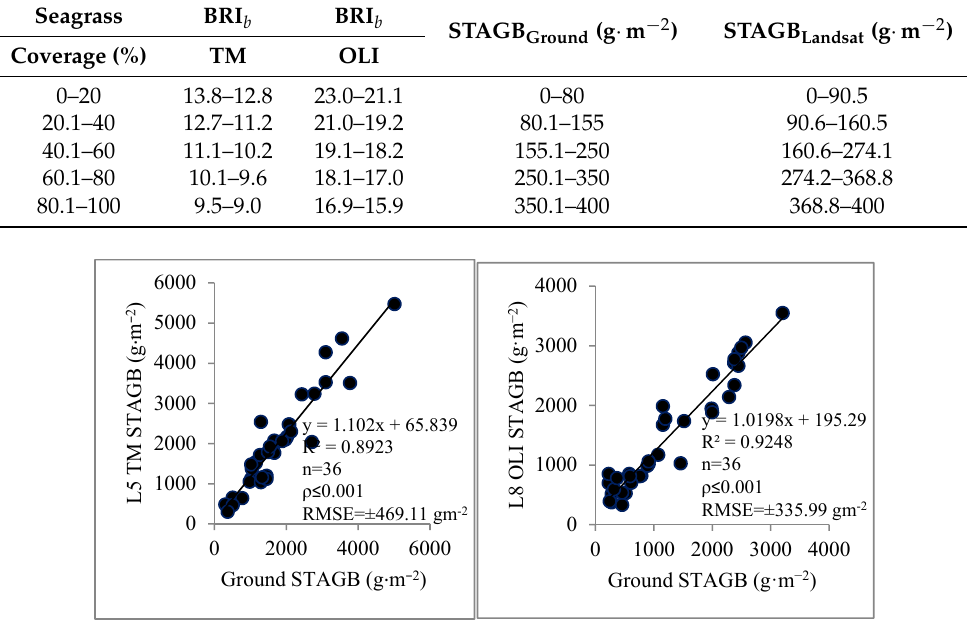
Figure 11. In situ seagrass biomass versus satellite-based estimation at corresponding location using 20 inductive sites and 16 test sites. Each plotted marker represents selected quadrats of seagrass sampling by 0.5 × 0.5 m quadrat, upscale to be equal to 30 × 30 m Landsat pixel.